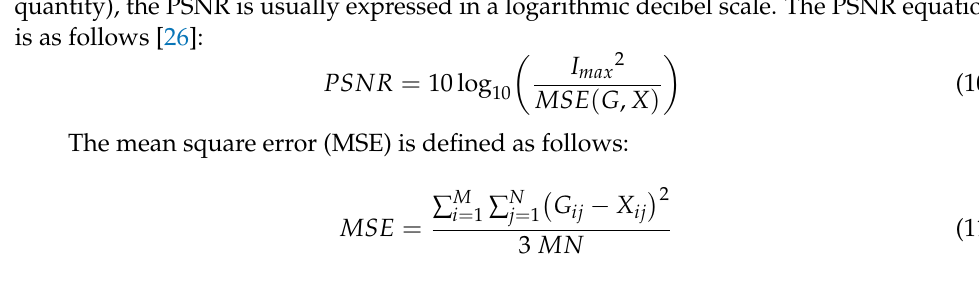
Figure 4. A SPECT image showing region of interest A (𝑅𝑂𝐼 𝐴 ) with a highlighted red square, as well as the background region ( 𝑅𝑂𝐼 𝐵 ) with a highlighted green square, for calculation of the signal-to- noise ratio (SNR) and contrast-to-noise ratio (CNR) indicators.